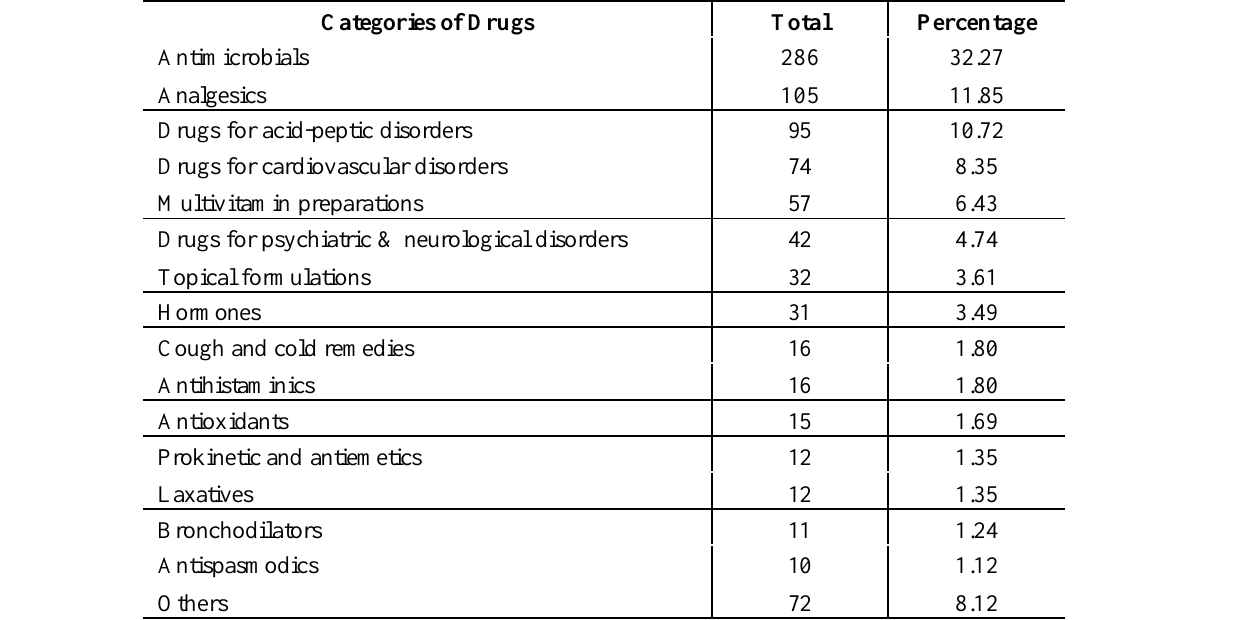
Table II : Distribution of Different Categories of Drugs in the Prescriptions Collected from CMS, Bharatpur, Nepal Categories of Drugs